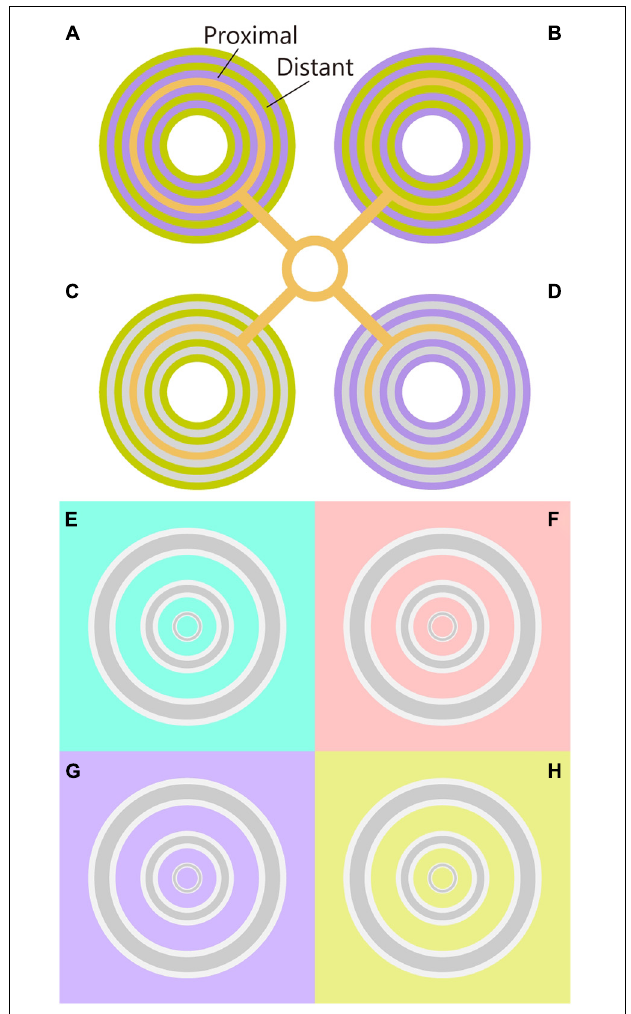
FIGURE 1 | Chromatic induction demos. (A,B) The original Monnier–Shevell illusion. Color appearance of center rings were different in panels (A,B) , although their physical chromaticity was the same. The chromaticity of the proximal and distant rings was inverted in panels (A,B) . The color appearance of the center ring was similar to the proximal color. Thus, the color appearance can be interpreted as the assimilation effect. (C,D) Chromatic contrast effect of the Monnier–Shevell illusion. Given that the chromaticity of proximal rings was achromatic, the assimilation effect from proximal rings was the same for panels (C,D) . Nevertheless, the color appearance of the center rings was different in panels (C,D) . Thus, the color appearance can be interpreted as the contrast effect from the distant rings. (E–H) The chromatic induction demos (Kanematsu and Koida, 2020). The color appearance of gray rings differed among the chromaticities of the backgrounds (E–H) although the physical chromaticity of the rings was the same. Concentric gray rings were flanked by white contours. The innermost ring appeared reddish on the cyan background (E) , and cyan on the red background (F) . Moreover, all the rings appeared yellowish on the violet background (G) and bluish on the yellow background (H) . Note: please adjust the viewing distance for the effective illusion, and maintain a distance from the figure to maximize